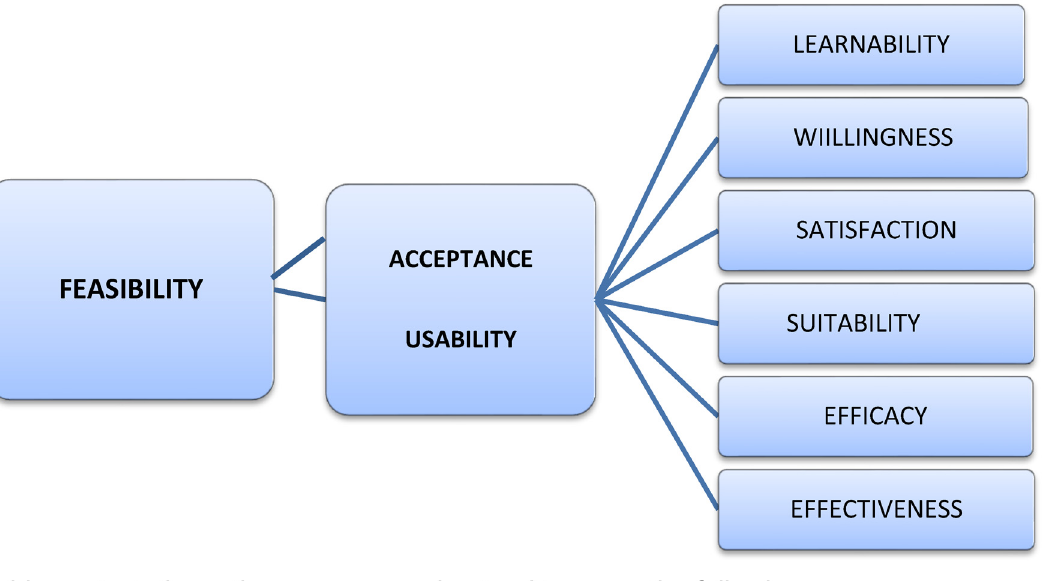
Fig 2. Conceptual framework for the evaluation of RST pilot study and national programme in Zambia, adapted from Asiimwe et al (2012). Legend: In this context, these themes were understood to mean the following: Learnability: how easy or difficult it was for HCW to learn to perform the RST, perform it accurately and learn about quality control and quality assurance; Willingness: Willingness of the HCW to perform the RST, to take part in the cascaded training i.e. being trained by or training other colleagues; willingness to take part in supervisory and quality assurance activities; Suitability: HCWs ’ belief the RST test was relevant to their work and could be successfully integrated into existing services; HCWs ’ belief in the appropriateness of the current supporting components of the RST programme i.e. training, supervision and quality maintenance; Satisfaction: HCWs ’ satisfaction with the test itself, its impact on workflow and satisfaction with the supporting components of the programme; Efficacy: Ability of HCWs to implement same-visit testing and treatment (STAT), to incorporate the test and to integrate quality assurance and quality control activities into their workflow; Effectiveness: How the organisational and systemic environment, including implementation of policy, guidelines, supply chain and other logistics, impacted on successful delivery of the programme. In addition, how the social context (the community, patients and their partners) influenced programme